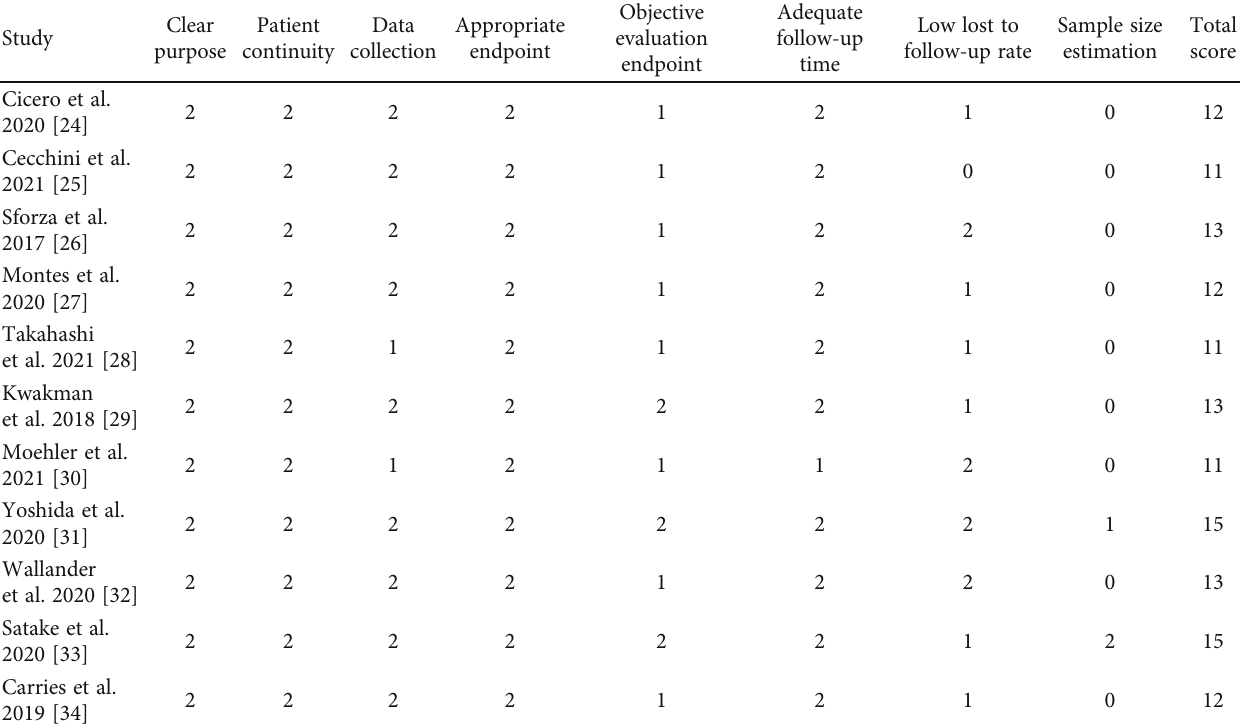
Table 3: MINORS quality evaluation for included uncontrolled studies.